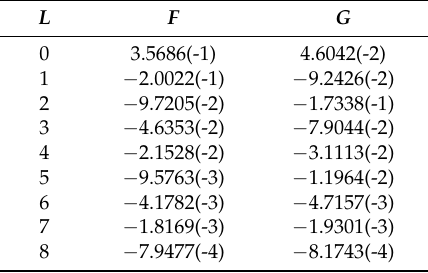
2 a π for various values of k and comparison 0 ) for various values of k and comparison with 0